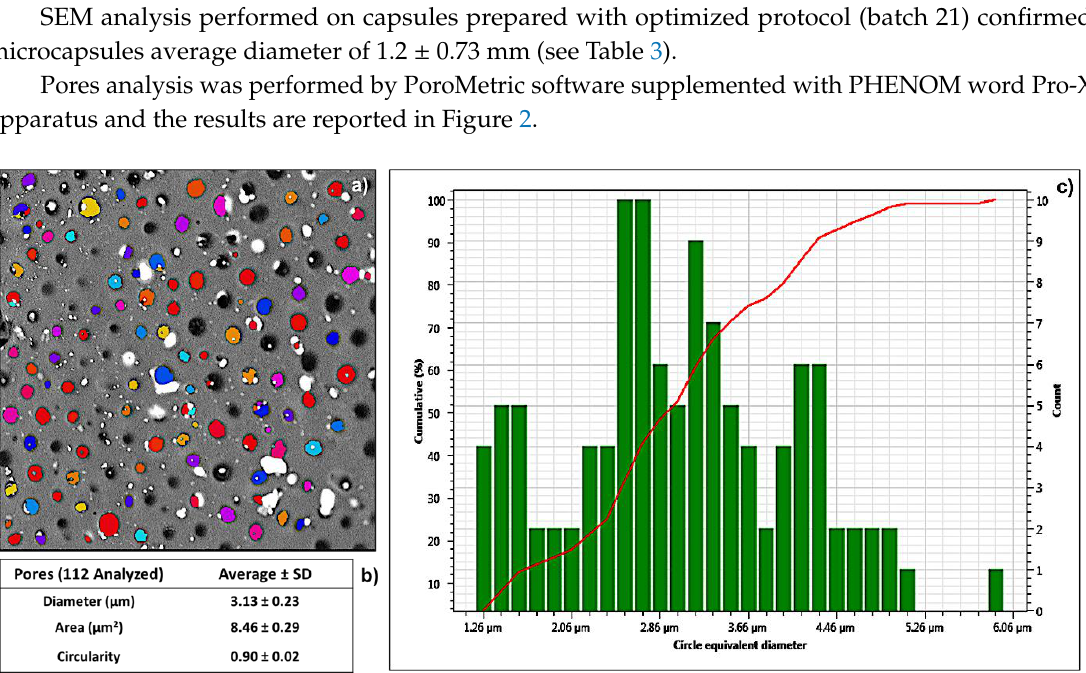
Figure 2. Porometer analysis performed on PMMA microcapsules. (a) Pores image and colorimetric identification; (b) table reporting values of pore diameter (μm), pore area (μm 2 ), and pocircularity value; (c) relation chart between cumulative analysis % and circle equivalent pores diameter (μm).